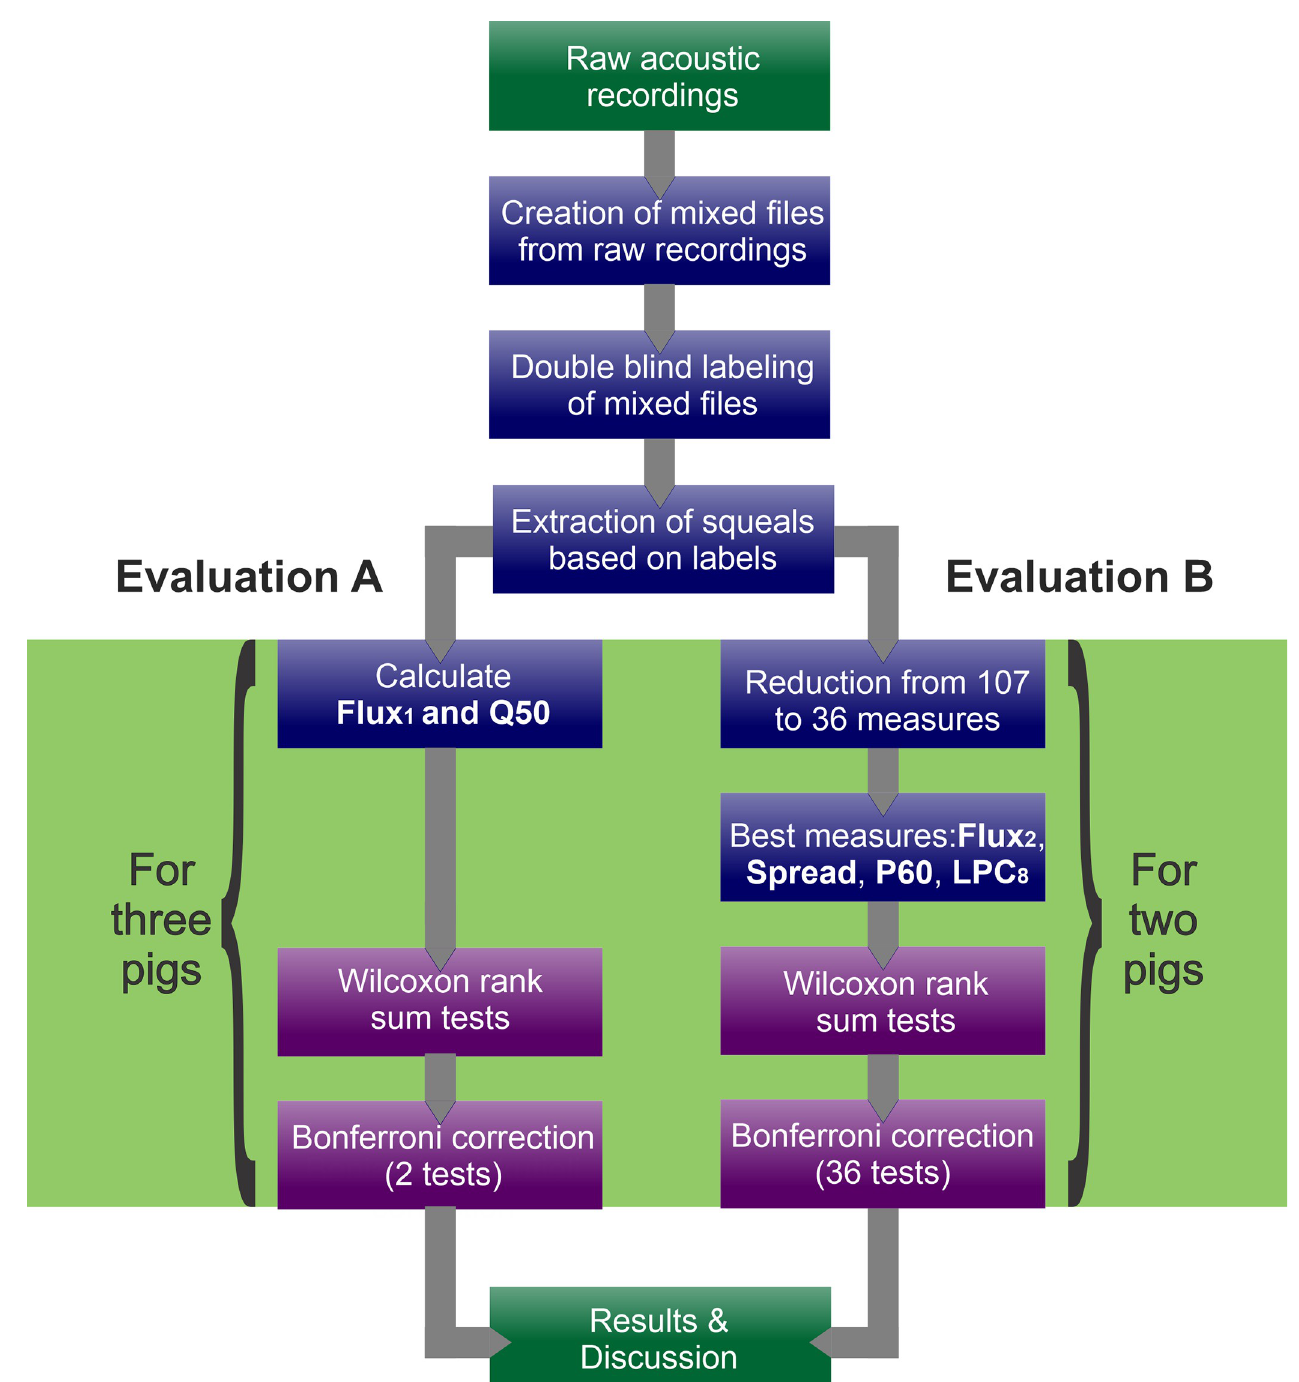
Fig 6. Summary of squeal analysis. In each pathway (evaluation A and B), preoperative and early post-operative (0–14 days) squeals were compared. Additionally, pig 4 had comparison of early versus late post-operative squeals. https://doi.org/10.1371/journal.pone.0284135.g006 larynx. Therefore, pig 1 had endoscopic injection of human adipose stem cells (hASCs), while pig 2 was maintained as an injured control. Pigs 3 and 4 underwent successful transcervical surgery for unilateral VF replacement. Pigs 5 through 8 underwent successful unilateral or